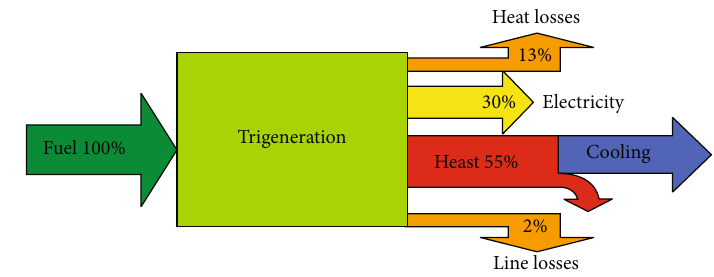
Figure 10: Energy balance in trigeneration [153].